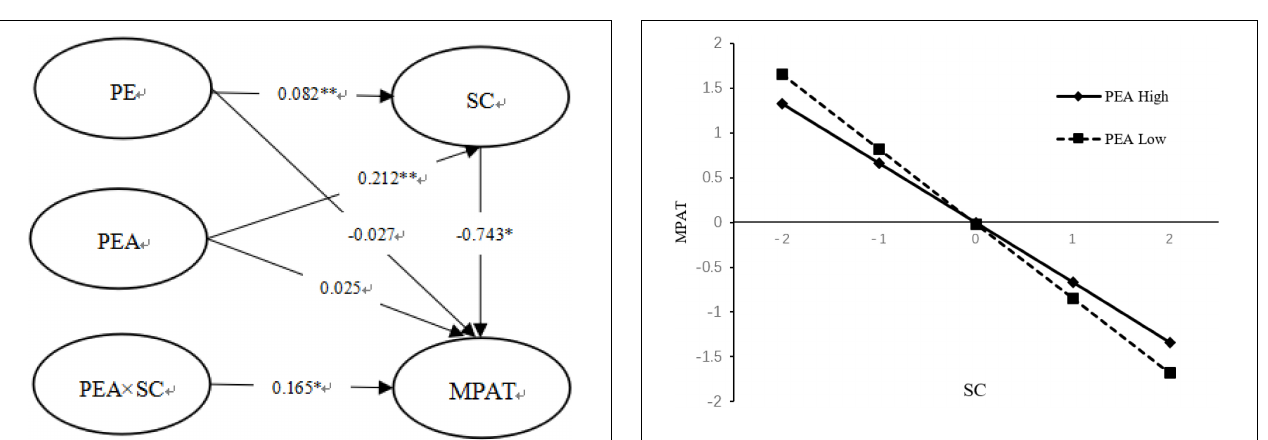
on MPAT of university students is a moderated mediating effect.